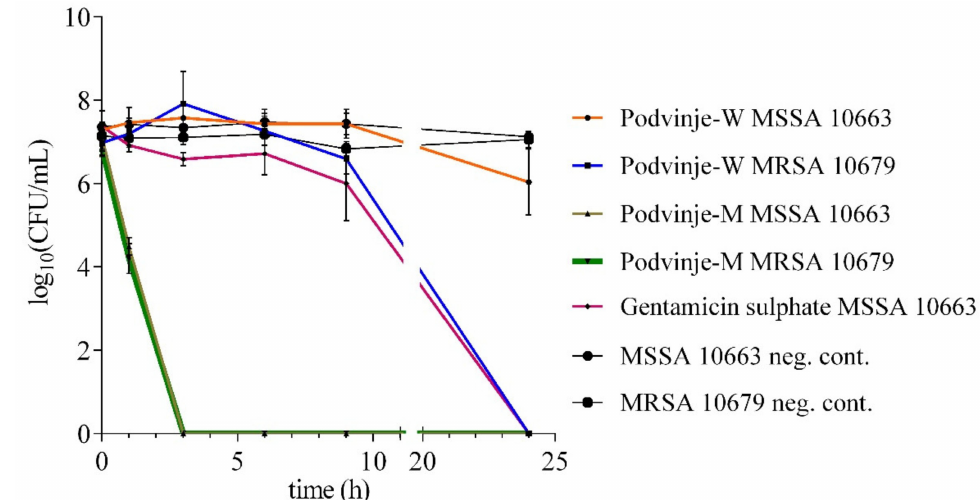
Figure 1. “Time-kill” assay of E. cicutarium water (Podvinje-W) and methanolic (Podvinje-M) extracts from the Podvinje locality on MSSA and MRSA strains (CFU, colony forming unit).